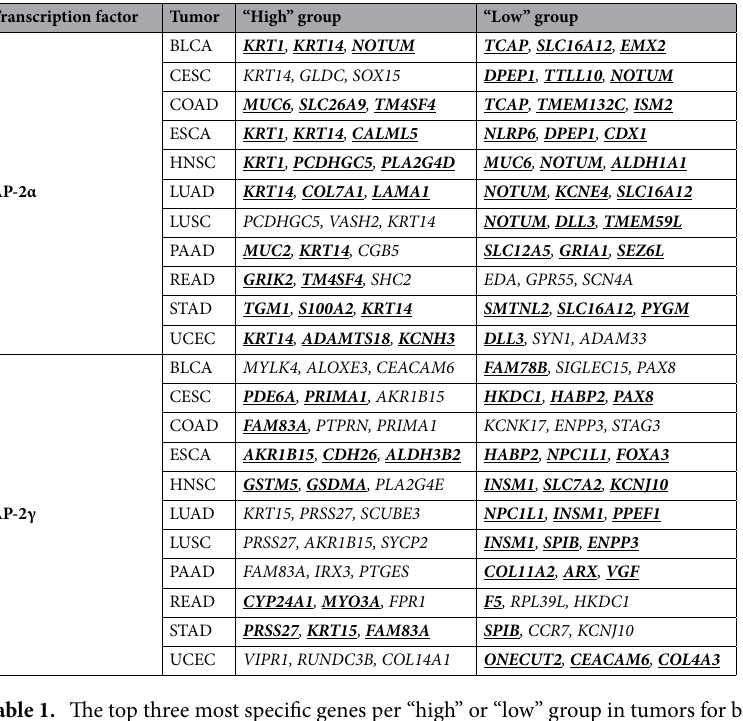
Table 1. The top three most specific genes per “high” or “low” group in tumors for both AP-2α and AP-2γ. Underlined and in bold are genes that met > 0.6 requirement in terms of specificity estimated by top_markers().